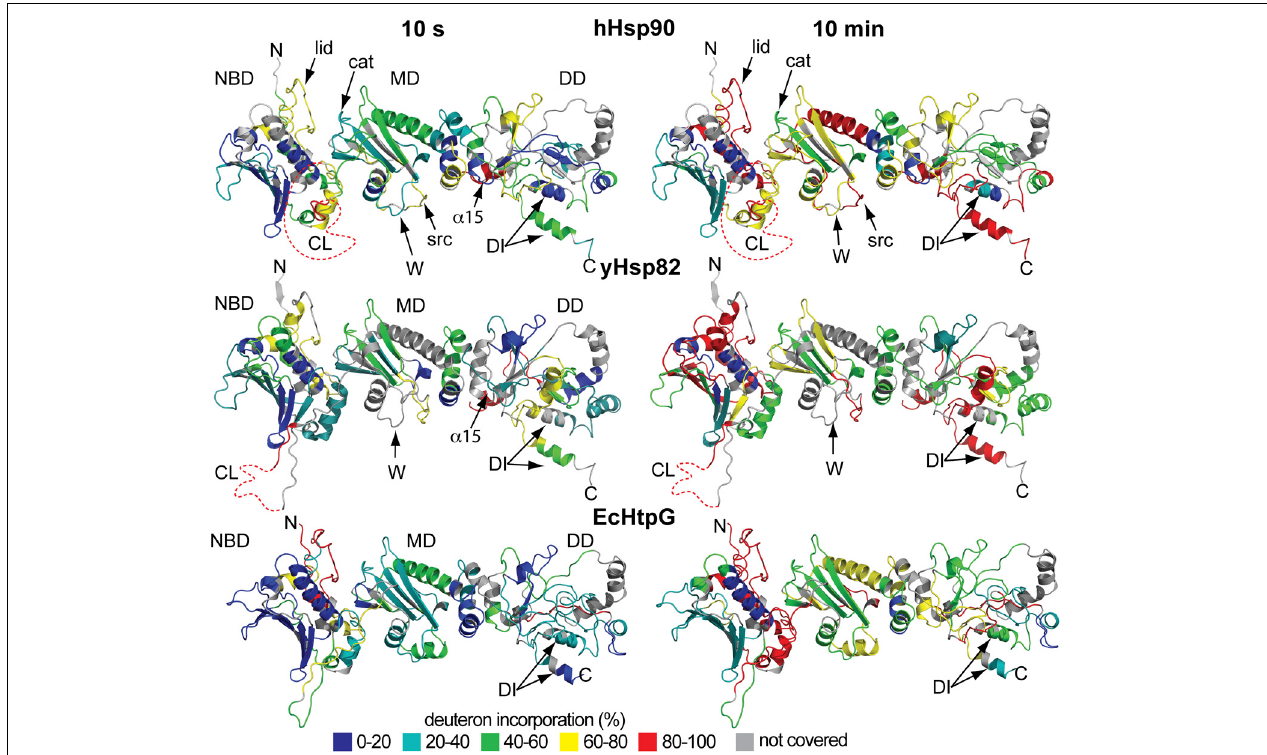
FIGURE 3 | Localization of fast and slow exchanging regions within the three Hsp90 proteins. Secondary structure representations of a homology model of hHsp90 onto the structure of yHsp82 [PDB ID code 2CG9; (Arnold et al., 2006; Guex et al., 2009; Kiefer et al., 2009); upper panels], the crystal structure of yHsp82 (PDB ID code 2CG9; middle panels), and a homology model of EcHtpG onto the structure of yHsp82 (PDB ID code 2CG9; lower panels)coloredaccordingtothedegreeofdeuteronincorporationafter10s(left panels) and 10min (right panels) as indicated. N, N terminus; C, C terminus;